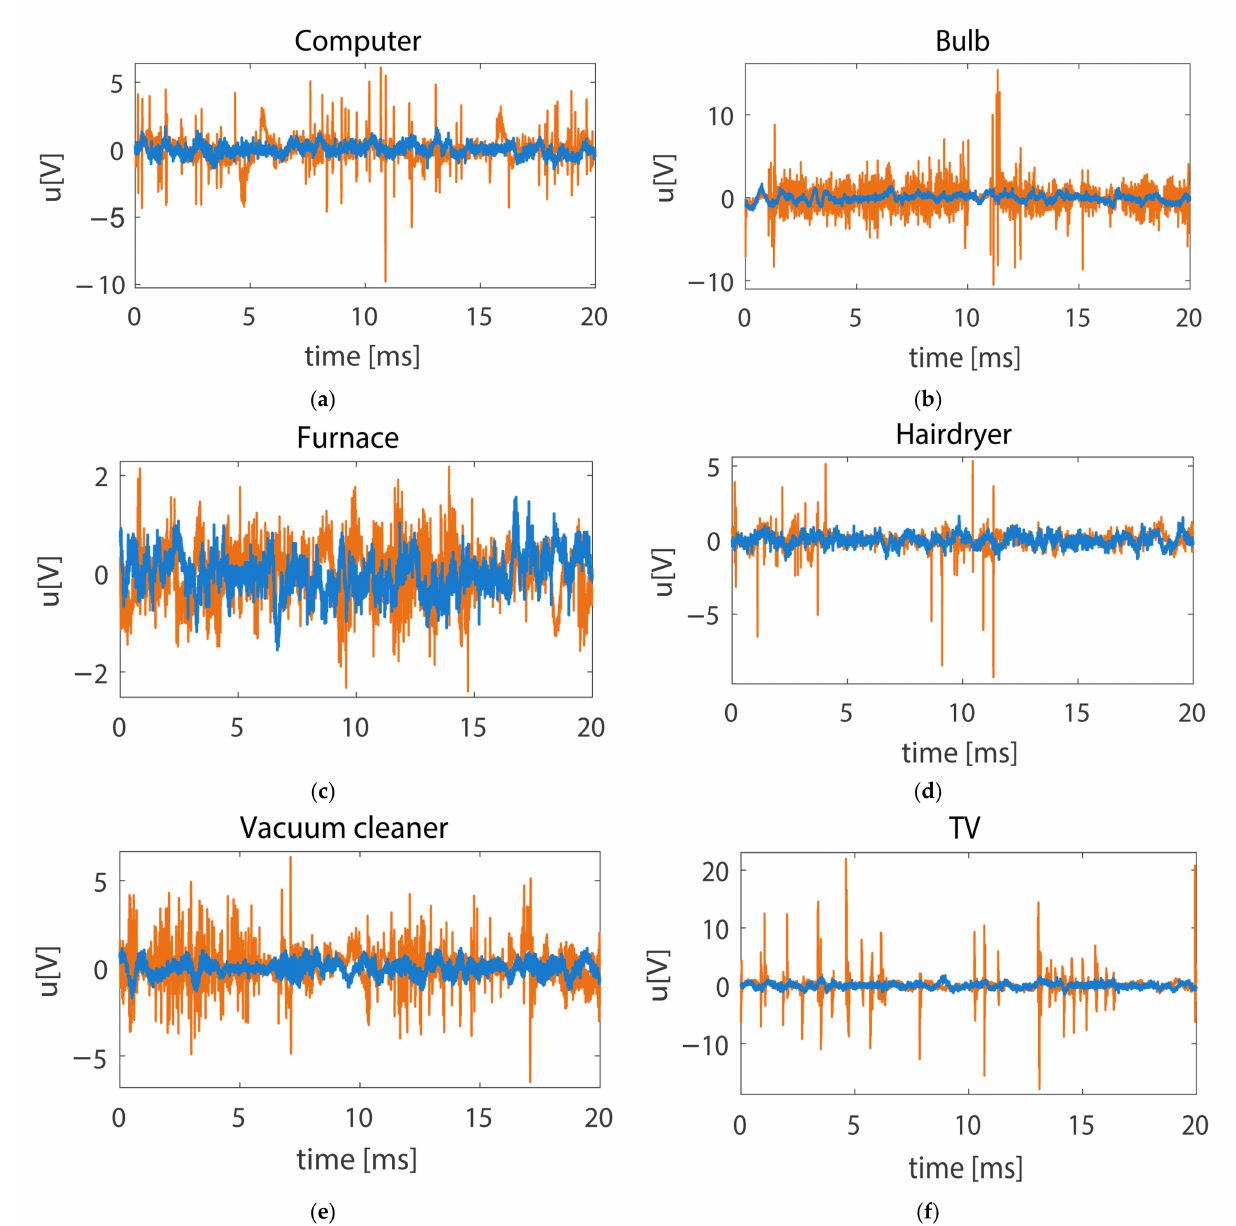
Figure 8. Changes between adjacent cycles of voltage signal for individually operating appliances with (orange line) or without (blue line) presence of series arc fault. ( a ) computer, ( b ) bulb, ( c ) furnace, ( d ) hairdryer, ( e ) vacuum cleaner, ( f )